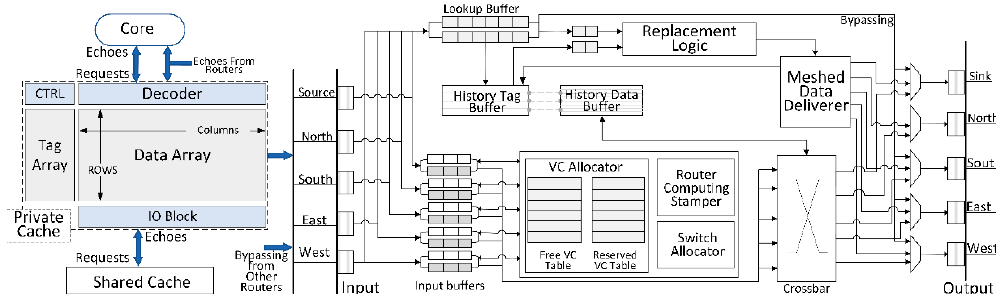
Figure 4. Proposed router architecture which is enhanced with three key components based on a conventional router [6,13].